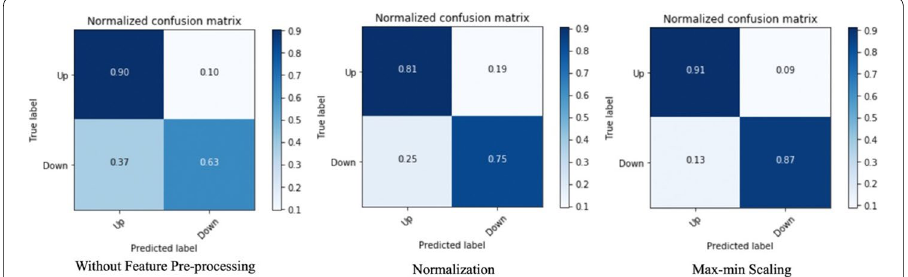
Fig. 8 Confusion matrices of different feature pre-processing